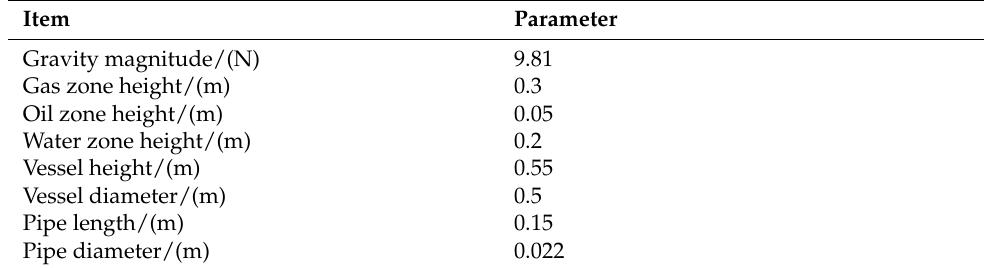
Table 1. Boundary conditions of the numerical model.